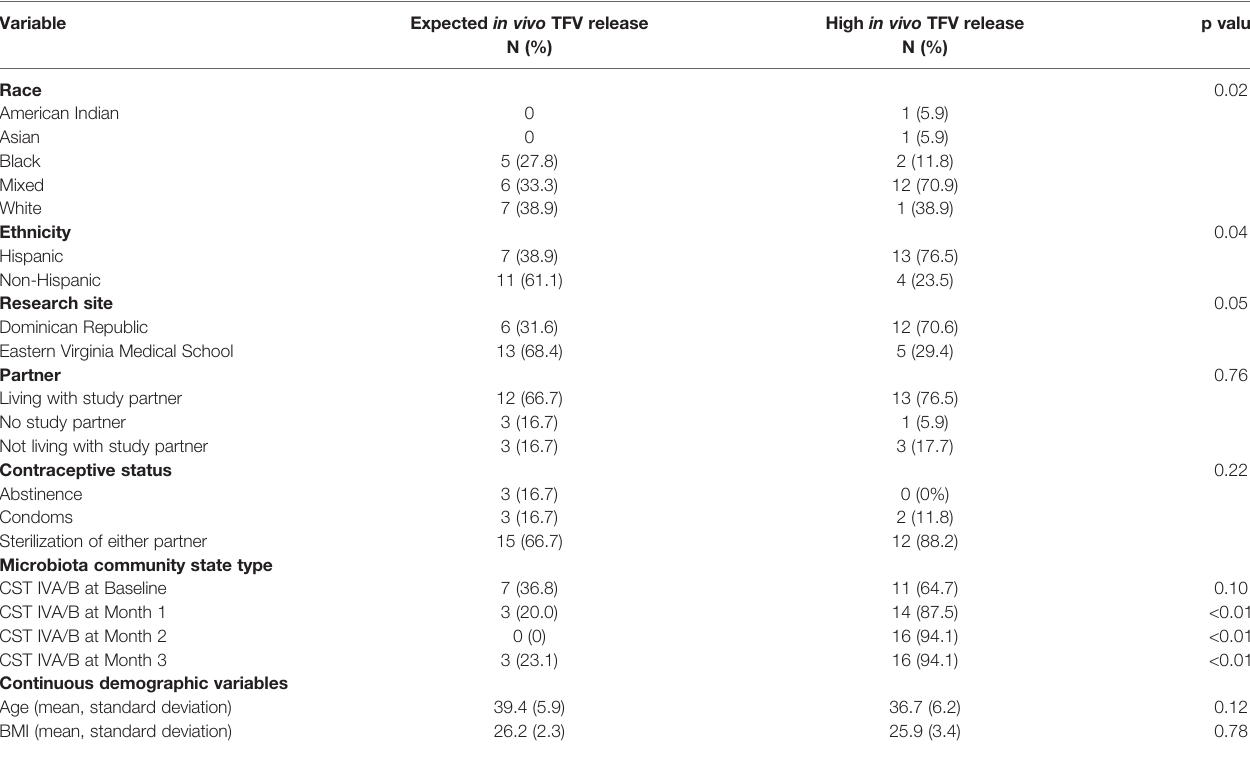
TABLE 2 | Demographic differences between participants based on high versus expected in vivo TFV release rates.